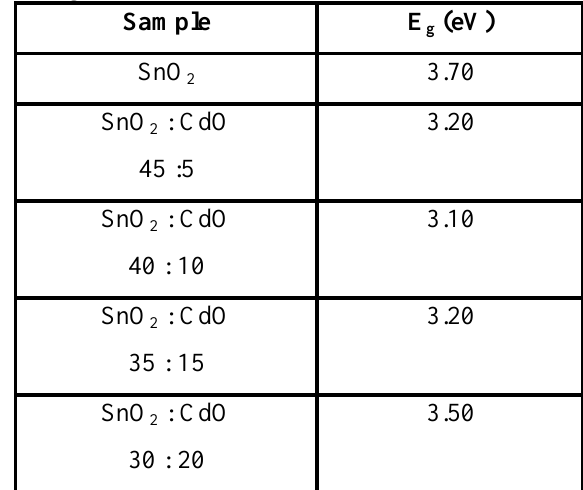
mixture with CdO at different concentrations. 2